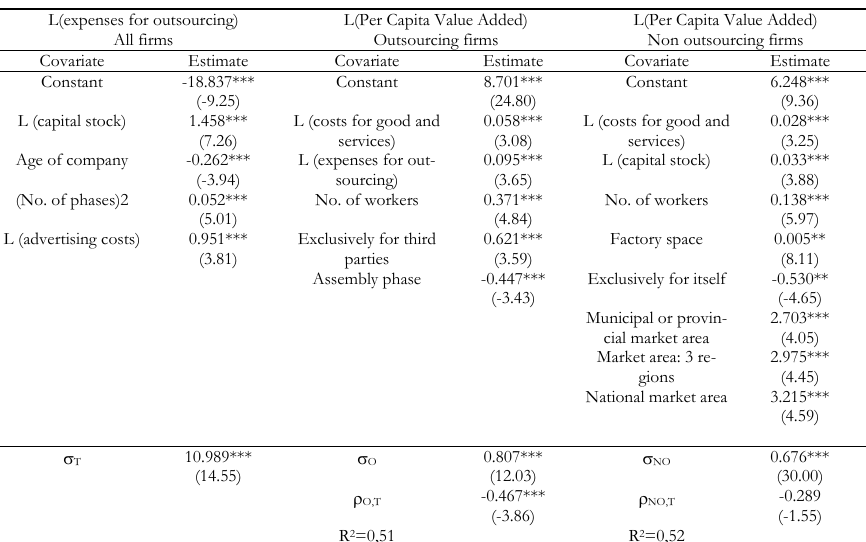
Results for firms with employees: effects on Per-Capita Value